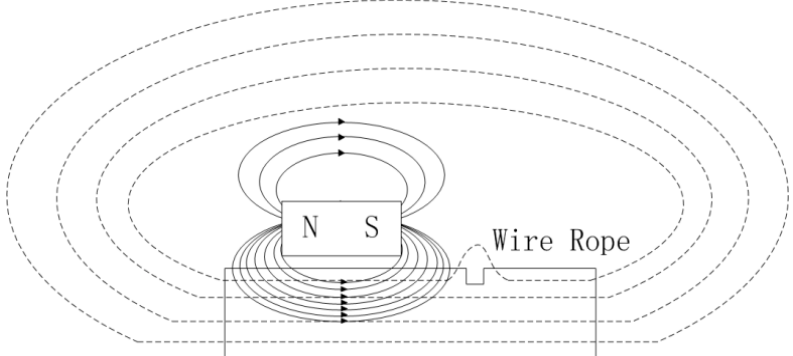
Figure 1. The principle of the unsaturated magnetic excitation (UME) testing method. The solid line represents the magnetic loop of the excitation source; the dotted line represents the wire rope inner magnetic field.